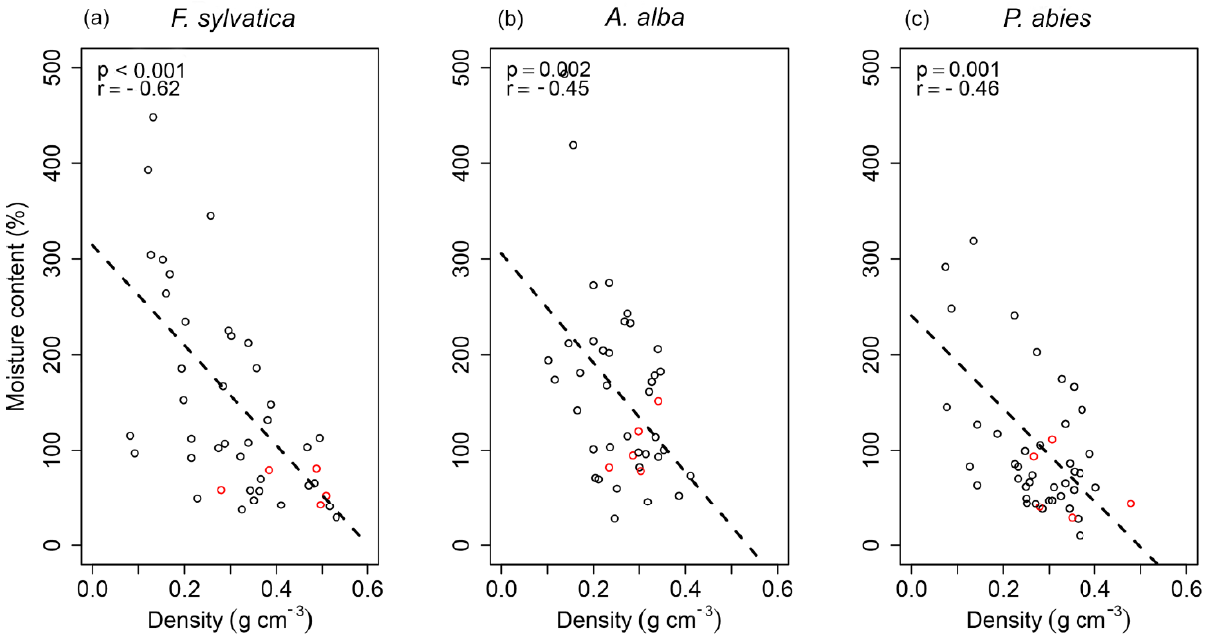
Figure 4. Correlation between the moisture content and wood density for each tree species: ( a ) F. sylvatica ; ( b ) A. alba ; ( c ) P. abies . Red circles — logs without ground contact.